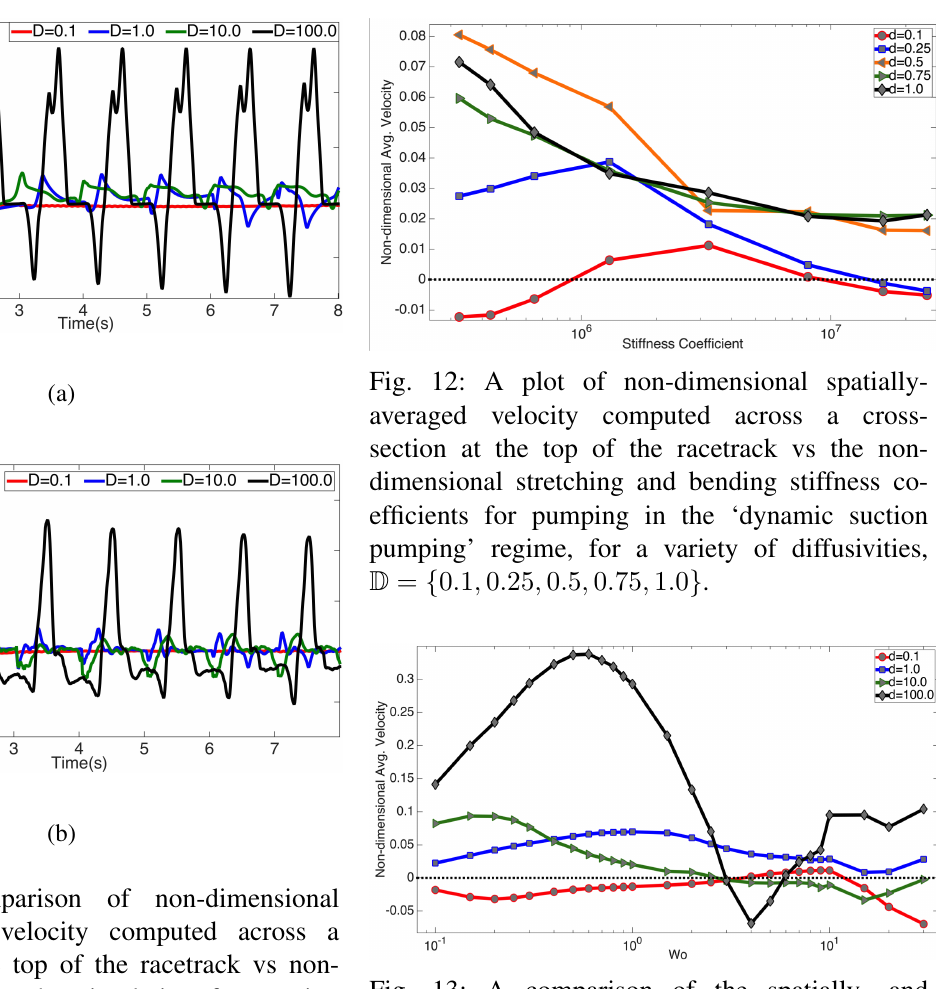
Fig. 13: A comparison of the spatially- and temporally-averaged non-dimensional velocities computed across a cross-section of the race- track vs. W o for varying diffusivities, D = { 0 . 1 , 1 . 0 , 10 . 0 , 100 . 0 }